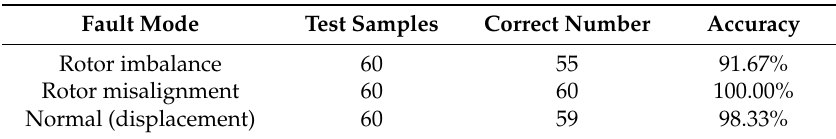
Table 2. Diagnosis result and correct rate using displacement CNNs.